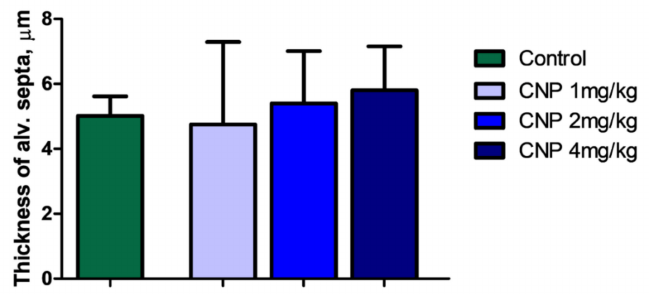
Figure 12. Thickness ( µ m) of rat alveolar septa at 14 days after intravenous administration of CNP suspension. Mann–Whitney test. Median ± range.